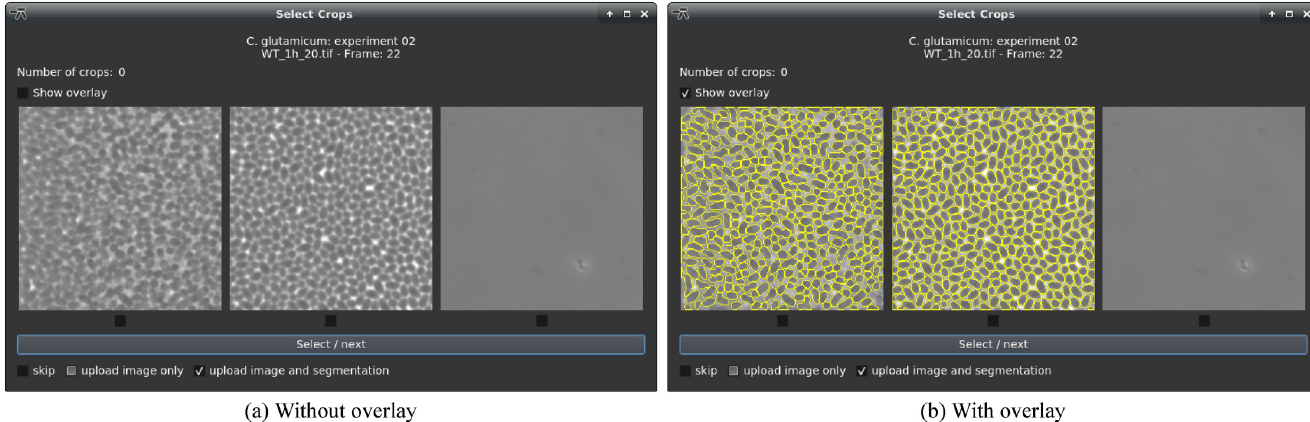
Fig 3. Crop creation interface. Automatically proposed crops can be selected and uploaded to OMERO (a). The crop proposals are extracted randomly from different non-overlapping image regions (the left crop originates from the left image region, and the right crop from the right). For the pre-labeling, it is possible to upload only the image or the image with its prediction (b). The image-only upload is helpful when the pre-label predictions require too many manual corrections.